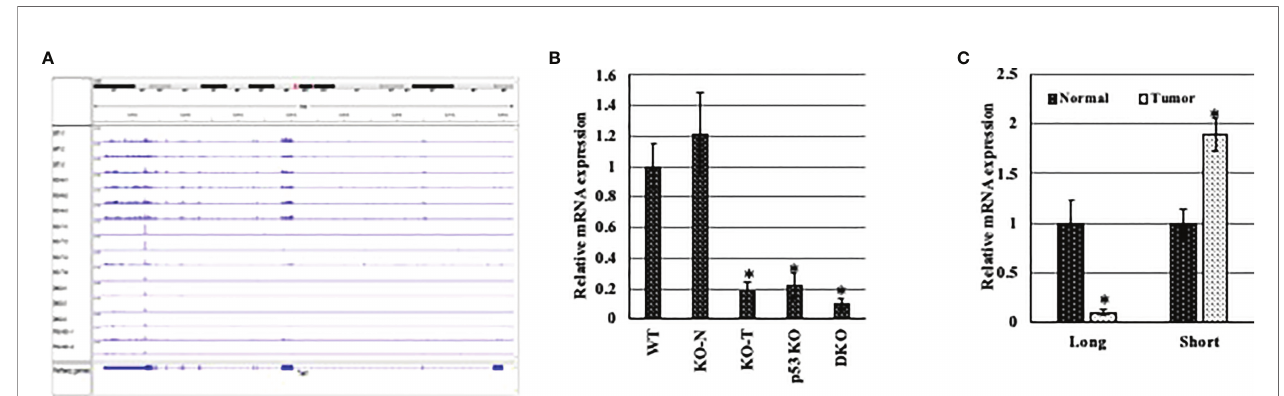
FIGURE 4 | Expression pattern of different Tet1 isoforms in different breast cancer animal models. (A) Visual presentation of RNA seq data for RNA extracted from conditional mammary gland p53 and Wwox single and double knockout (w-KO: Wwox knockout, p-KO: p53 knockout, D-KO: double knockout for both p53 and Wwox ) mice. RNA obtained from normal mammary gland tissue isolated from wild type mice (WT) or from pre-cancerous tissue of D-KO mice (N-KO) were used as control samples. (B) qRT-PCR on RNA extracted from conditional mammary gland p53 and Wwox single and double knockout (w-KO: Wwox knockout, p-KO: p53 knockout, D-KO: double knockout for both p53 and Wwox ) mice. RNA obtained from normal mammary gland tissue isolated from wild type mice (WT) or from pre- cancerous tissue of D-KO mice (N-KO) were used as control samples. (C) qRT-PCR on RNA extracted from mouse mammary tumors (black bars) and normal tissue (white bars), after DNase treatment, for Exons 1 (represents the longer Tet1 isoform) and 1.5 of Tet1 (represents the shorter isoform). The mRNA levels are shown after normalization to levels of Rpl0 . Bars represent SEM, n=6. * indicates that p-value is <0.05.